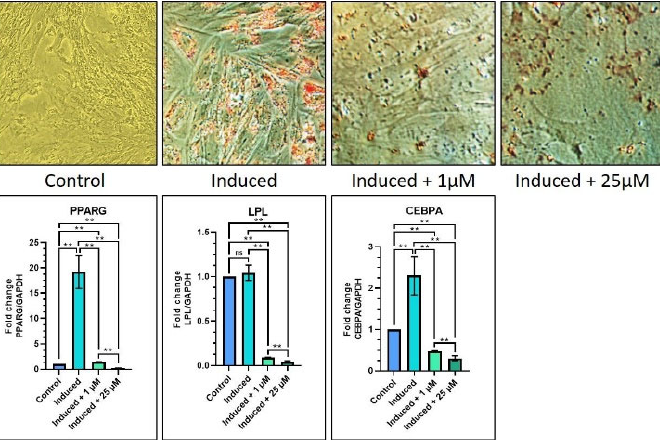
Figure 3. Comparative adipogenic differentiation (oil red O staining) of DPSCs with low (1 µ M) and high (25 µ M) concentrations of melatonin and RT-qPCR-based gene expression analysis of adipogenesis-related genes. Scale bar: 200 µ m. ns, not significant; ** p < 0.01.